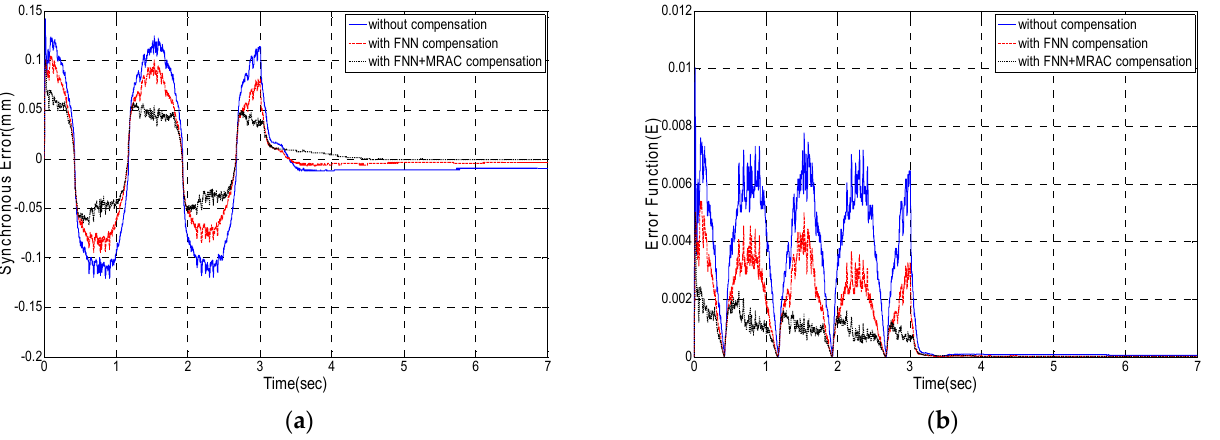
Figure 16. ( a ) The synchronous error under high-frequency commands; ( b ) the cost function under high-frequency commands.